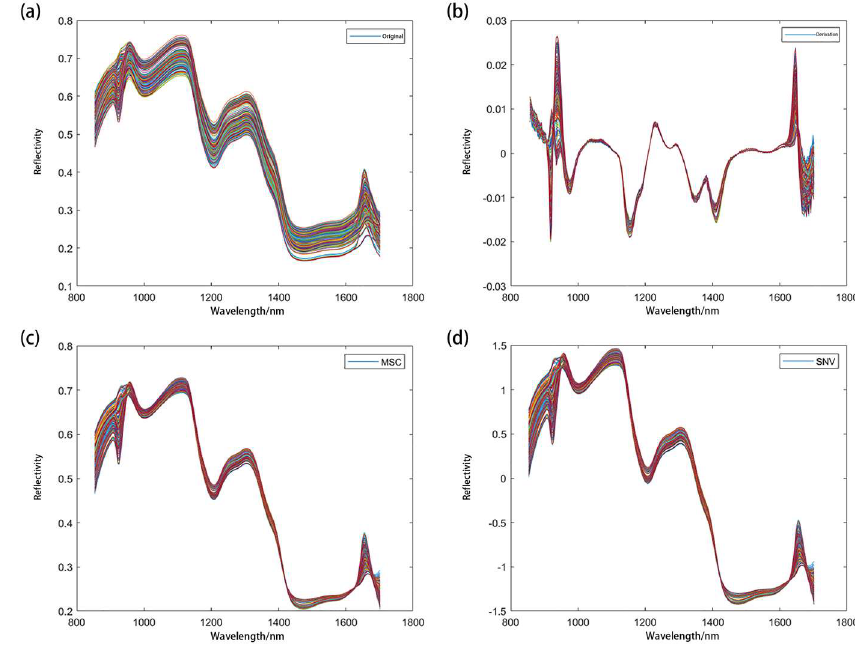
Figure 3. The spectra of original and preprocessed data.